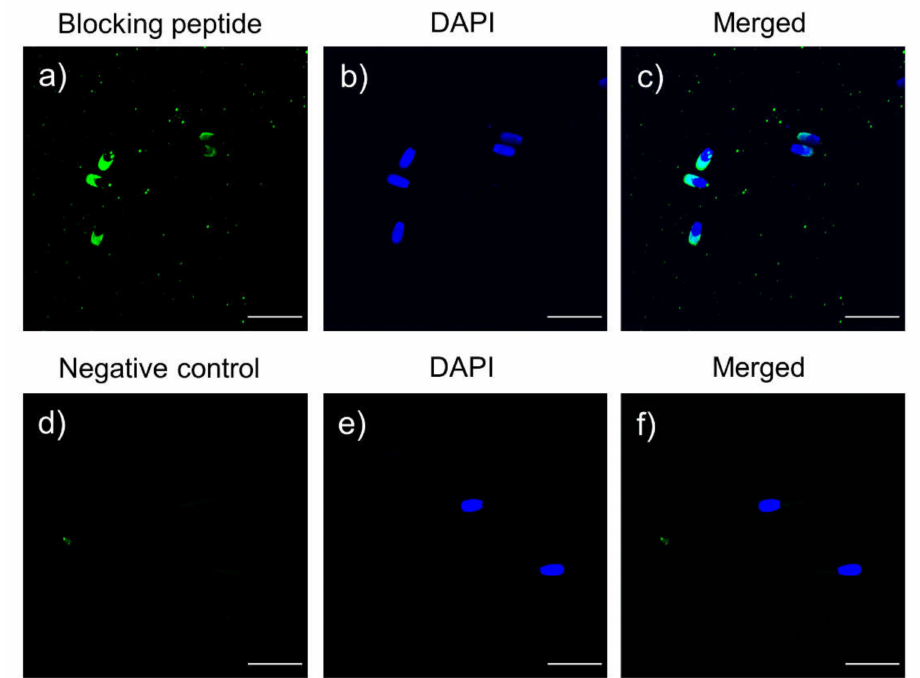
Figure 8. Immunofluorescence of the peptide competition assay for the anti-PARK7 antibody ( a – c ) and negative control ( d – f ). Green fluorescence indicates unspecific PARK7 staining, and nuclei are shown in blue (DAPI). Scale bar: 20 µ